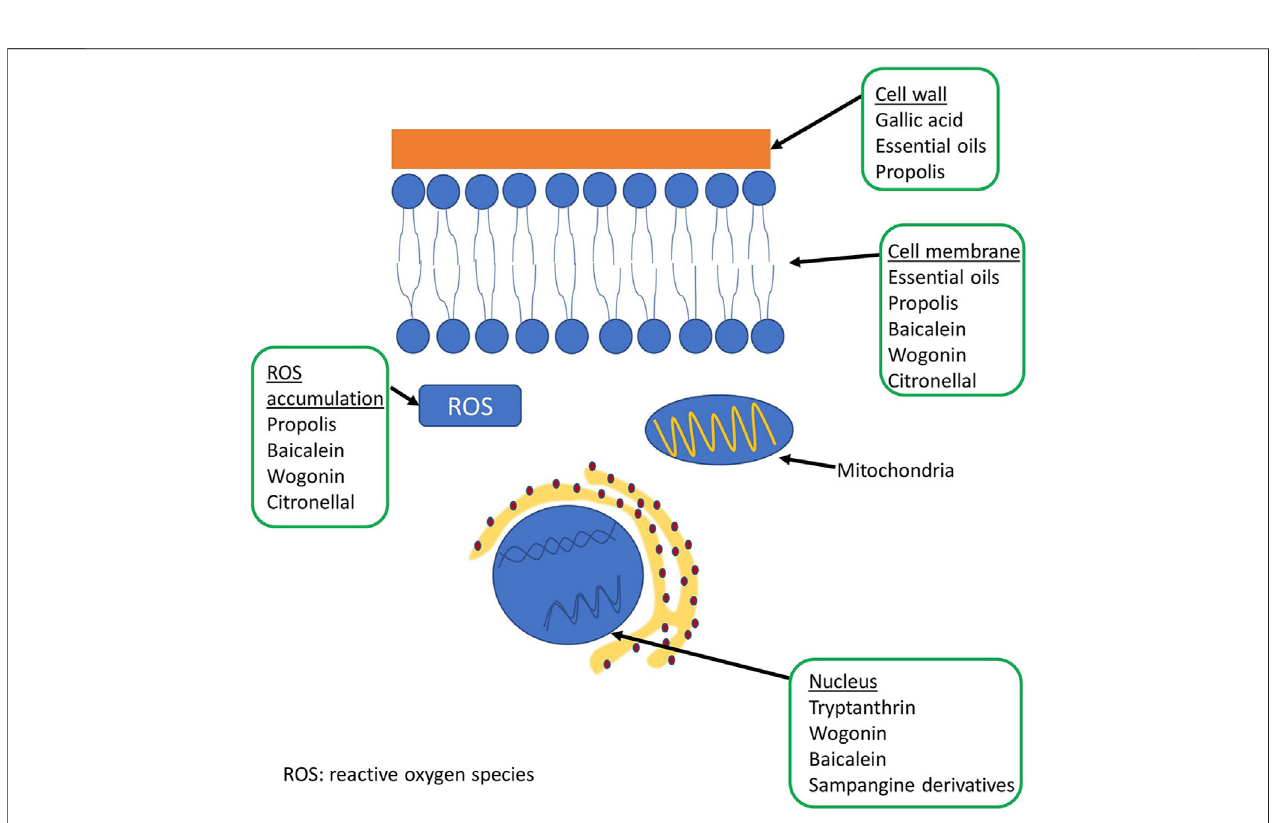
FIGURE 2 | Representation of the fungal cell structure and place of action of some natural compounds.